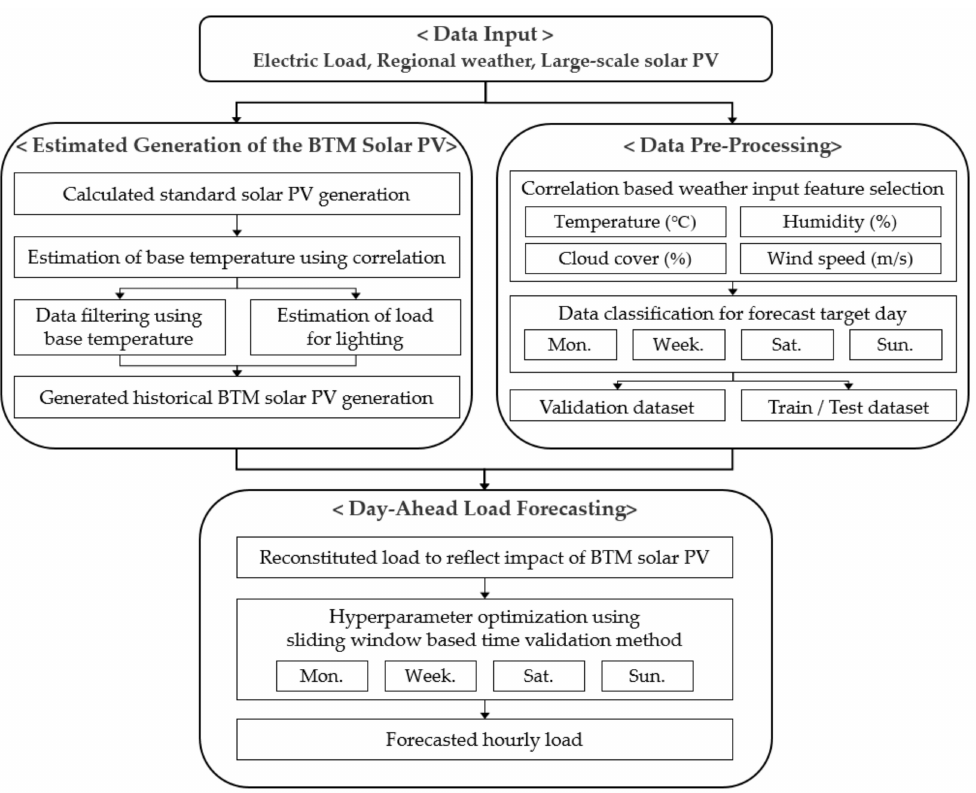
Figure 5. The overall framework of the proposed